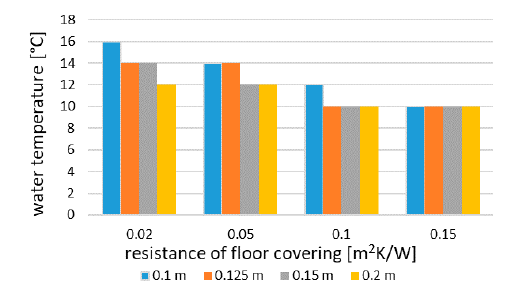
Figure 4. Admissible value of water temperature for variable thermal resistance of floor covering and pipe spacing (air temperature 26